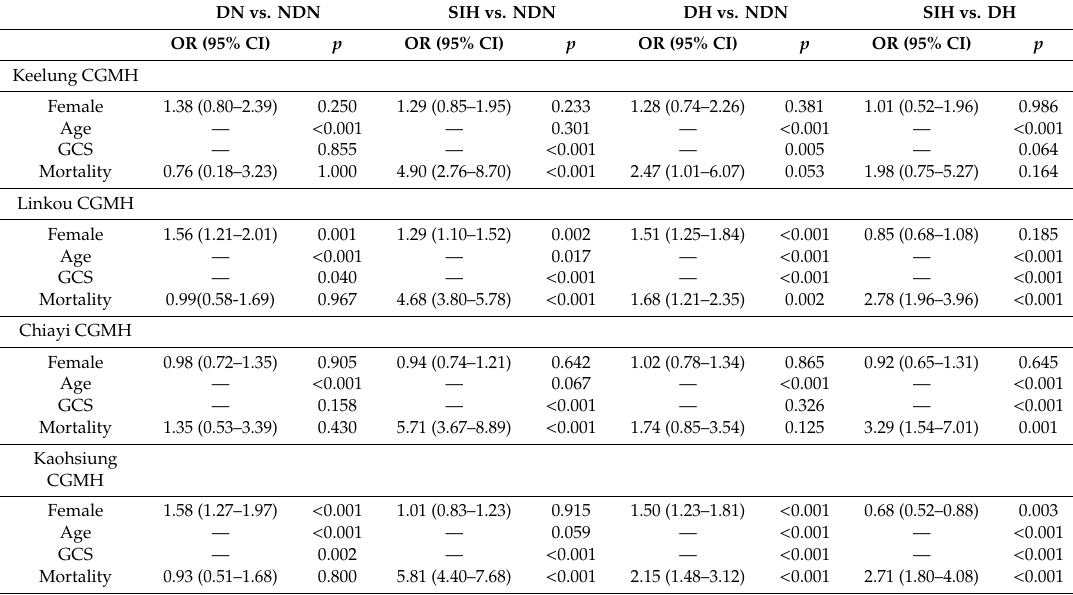
Table 2. Comparison among the four groups (NDN, DN, SIH, DH) of patients with traumatic brain injuries within each